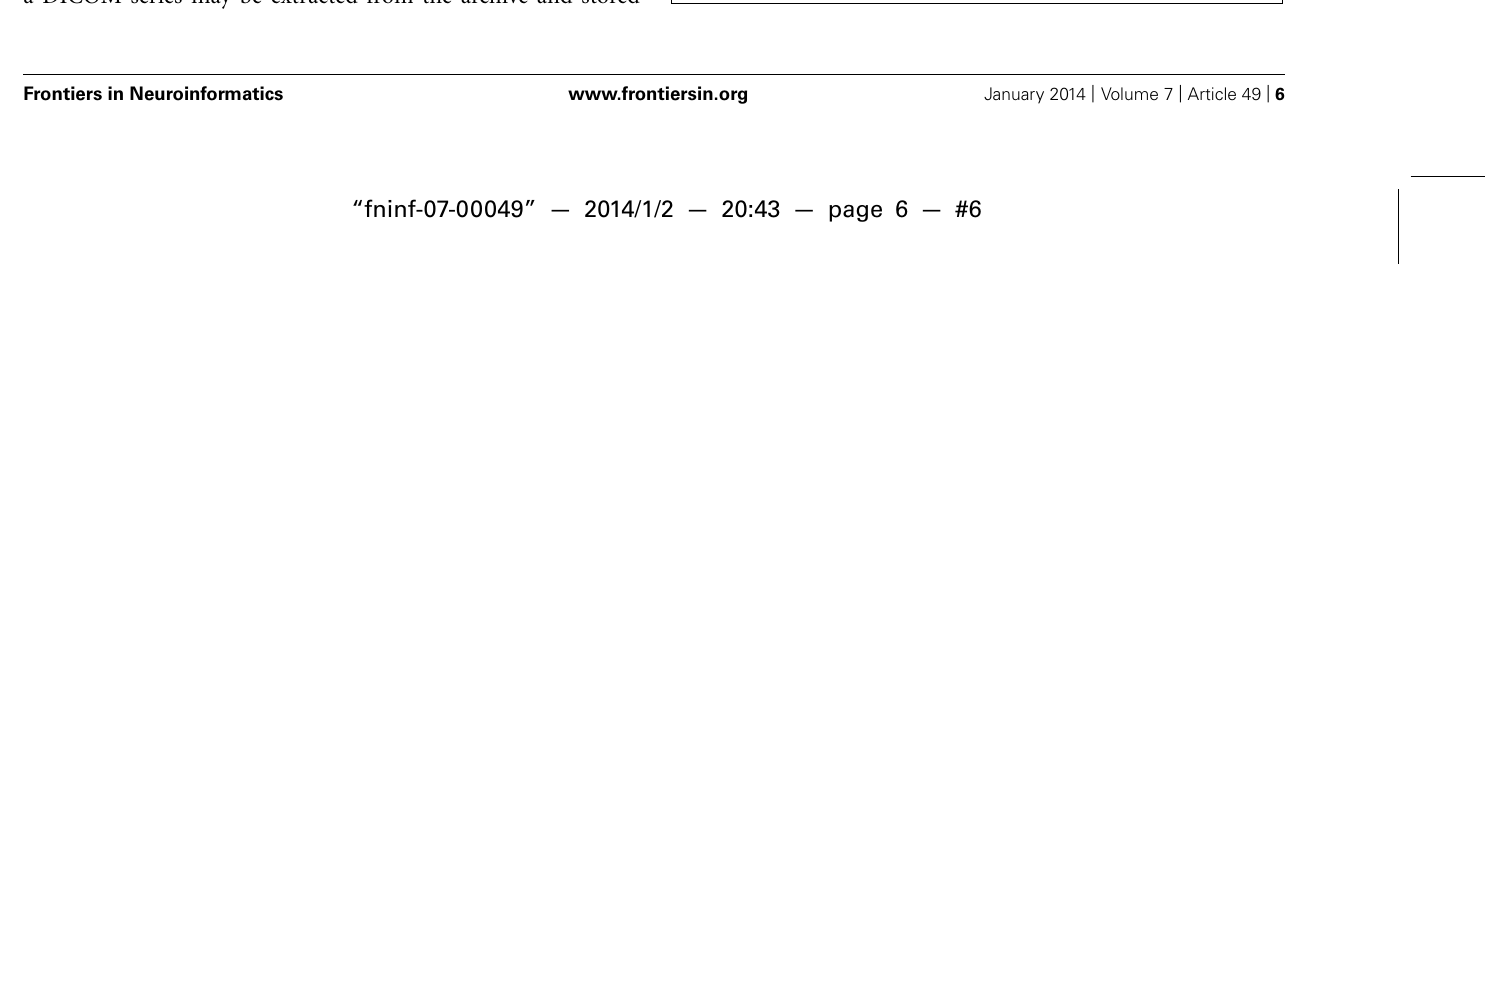
FIGURE 4 |TheHiveDB topology can be adjusted to individual requirements. Illustration of separate database instances per research lab and some compute resource sharing [ (A) to the left] versus collaborative setting with unified architecture [ (B) to the